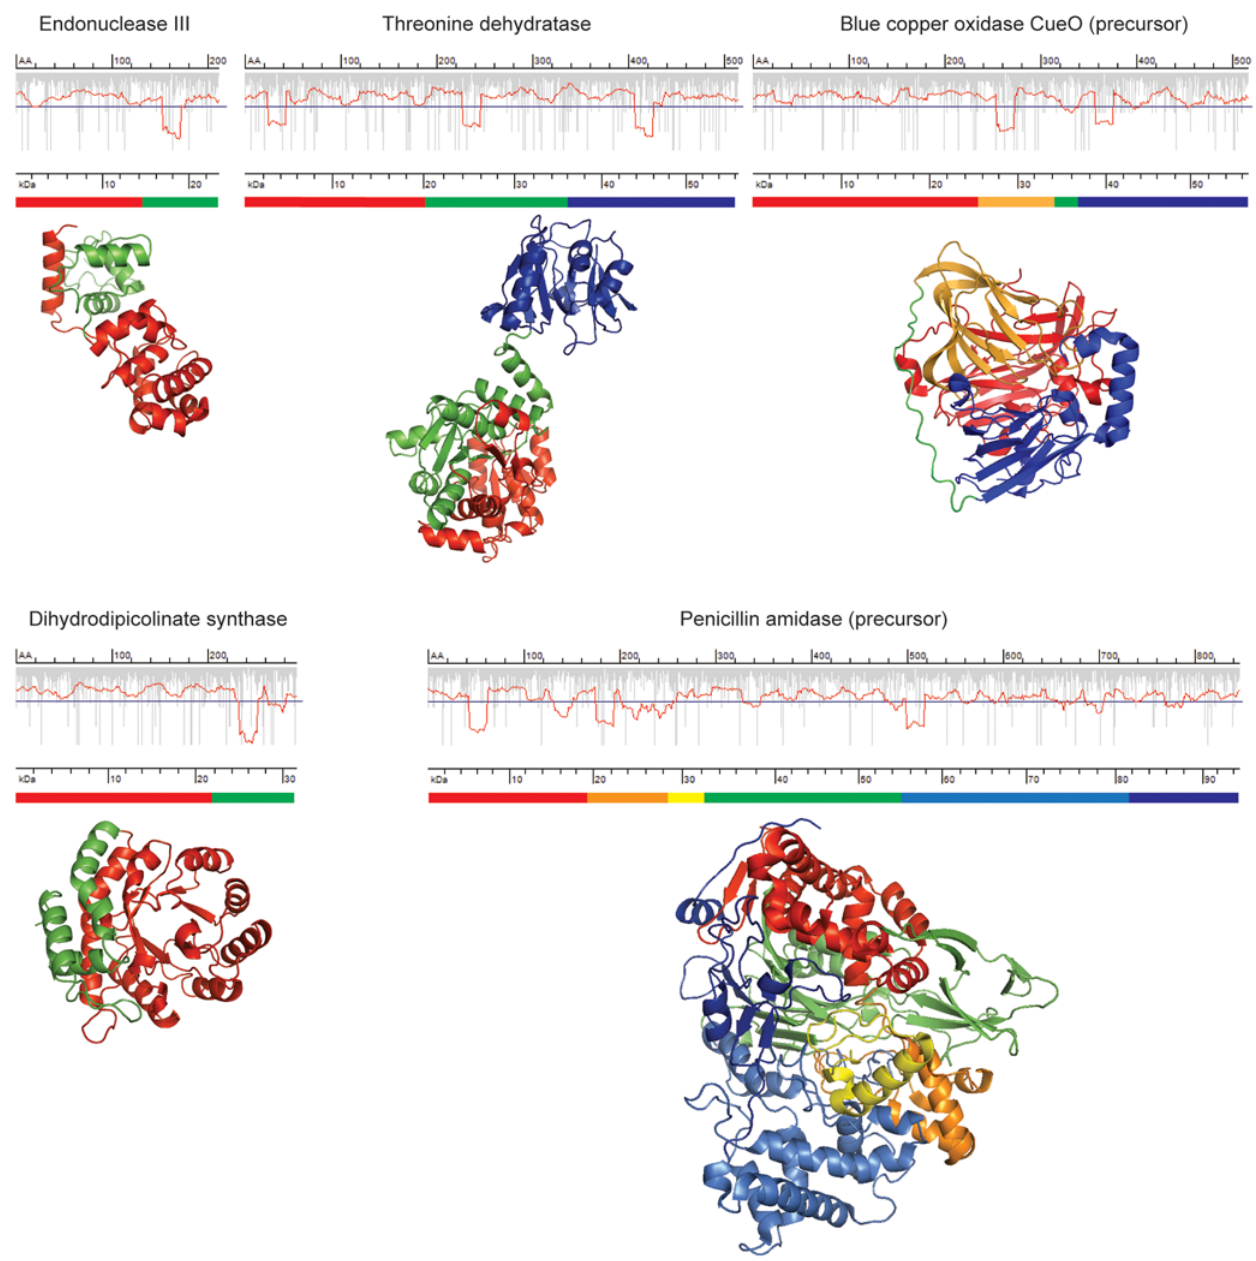
Figure 5. Putative sites of translational attenuation delinate the structural domains in the proteins. The domain architecture based on the primary amino acid sequence is schematically presented under the translation rate profiles, and the same color code is used to highlight different stuctural domains on the 3D-structure. The pdb-codes of the proteins are as follows: endonuclease III – 2ABK, dihydrodipicolinate synthase – 1DHP, blue copper oxydase CuoE – 1KV7, threonine dehydratase – 1TDJ, penicillin amidase – 1PNK. For details of the description of the translation profile plots see the legend to Fig. 1. Note that the putative site of ribosomal attenuation is 20–70 amino acids down-stream of the C-terminus of a domain.